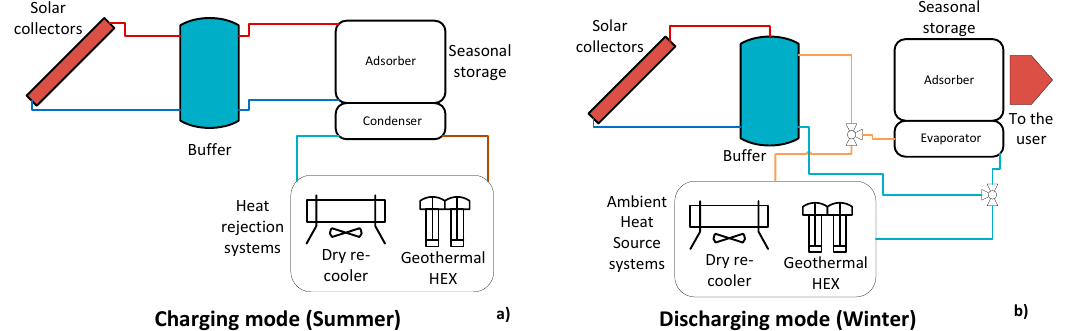
Figure 3. Reference system to which the analysis is applied. Charging mode schematically represented in ( a ) and Discharging mode in ( b ).